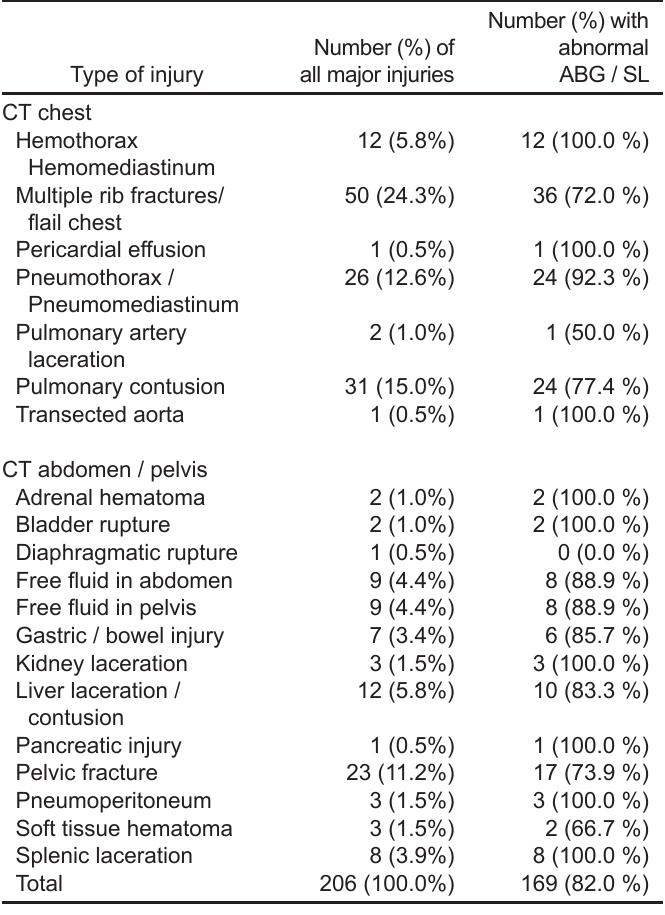
Table 5 . Major injuries identified on computed tomography (CT) of the chest, abdomen, and pelvis.